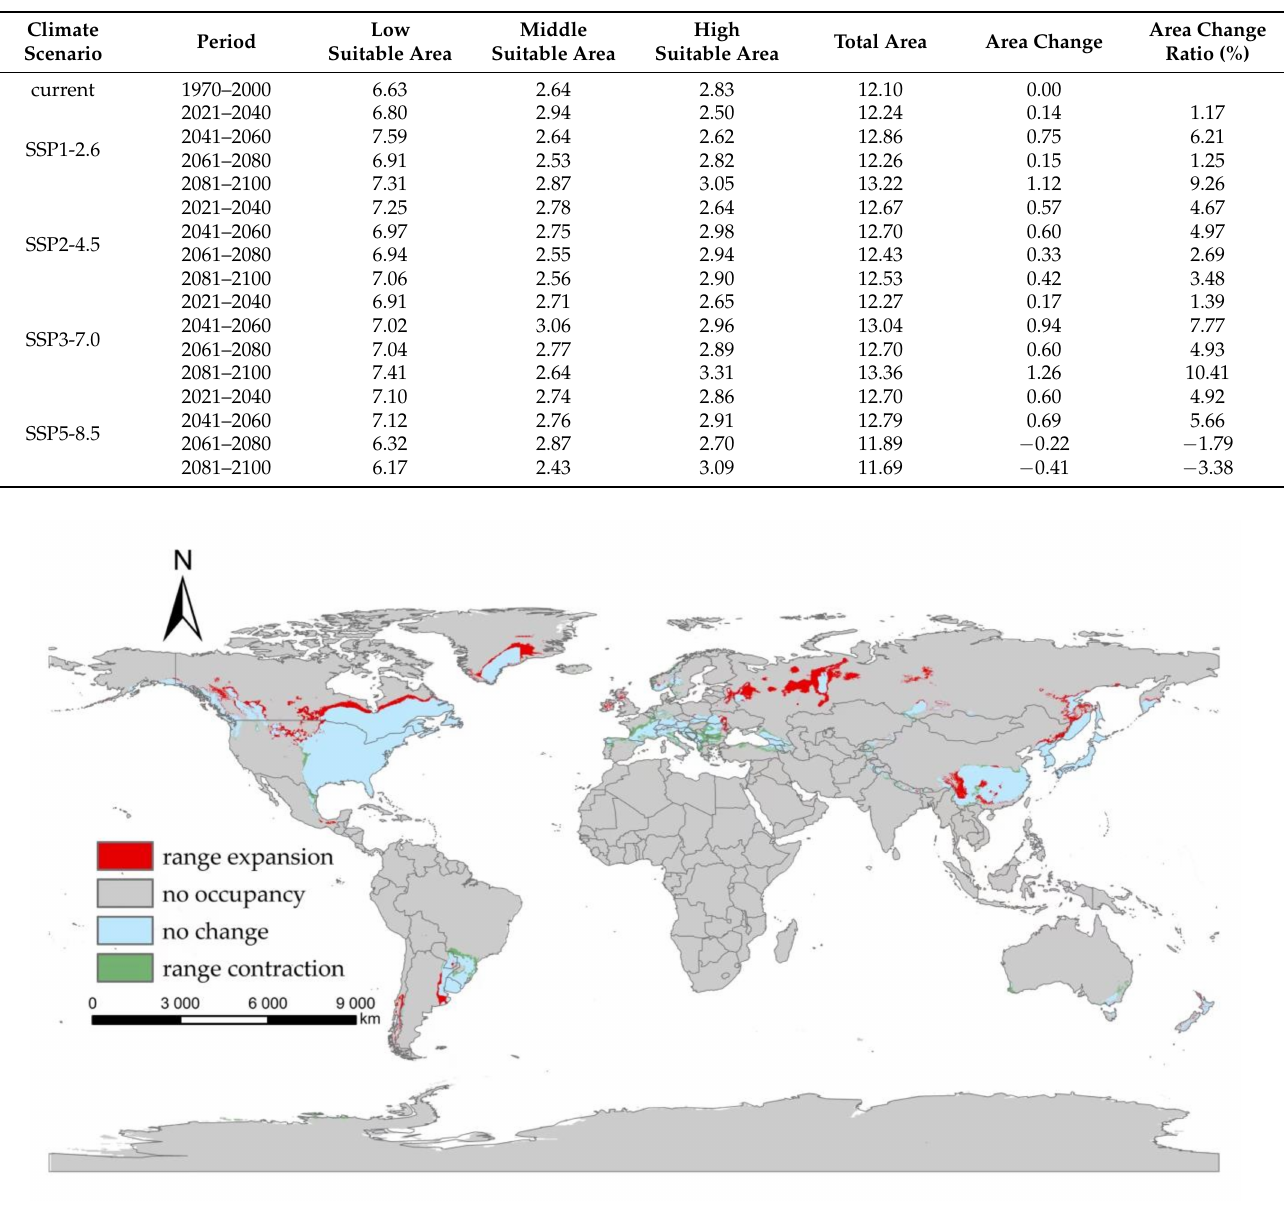
Table 2. Current and future suitable areas of I. scapularis under different climatic conditions ( × 10 6 km 2 ).